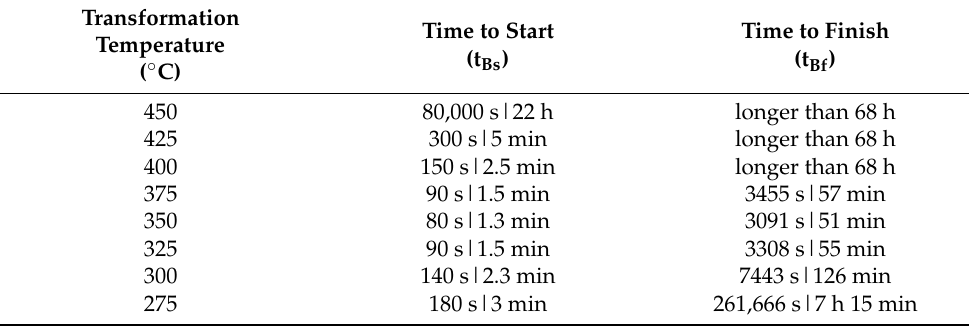
Figure 8. Microstructures of experimental steel after isothermal heat treatment at different temper- atures. ( a ) 750 ◦ C for 20 h; pearlite. ( b ) 575 ◦ C; pearlite for 68 h, degenerated pearlite, partially spheroidal. ( c ) 450 ◦ C for 68 h; lack of identified transformation, martensite. ( d ) 400 ◦ C for 64 h; partially transformed upper bainite and martensite. ( e ) 350 ◦ C for 3 h; lath morphology of bainitic ferrite and retained austenite (blocks and films). ( f ) 275 ◦ C for 15 h; lath morphology of bainitic ferrite, retained austenite (blocks and films). Scanning electron microscopy, etched by nital. Table 4. Bainite transformation times at different temperatures during isothermal